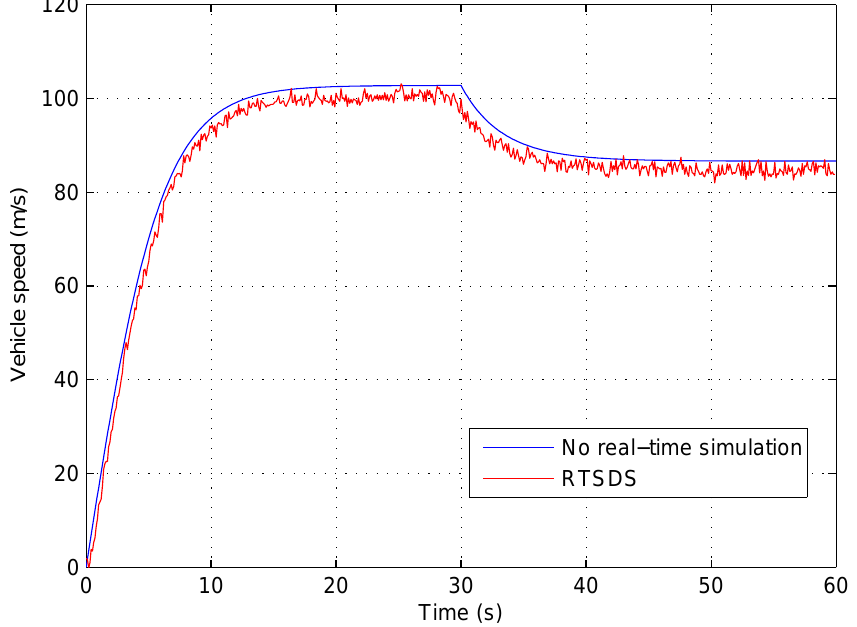
Figure 22. Results obtained for the RTSDS platform applied to the dynamic system ( t ) = 2000 Nm and θ ( t ) = 0 degree initially and, characterized by Equation (12), with τ m then, θ ( t ) = 30 degree after 30 s.